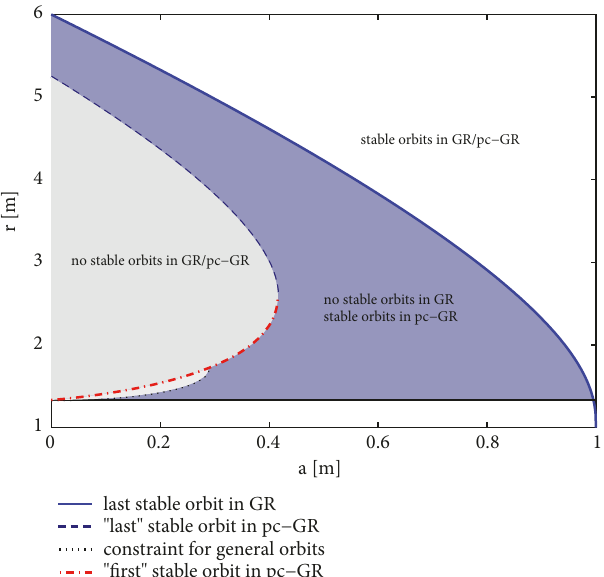
Figure2:Thepositionofthe InnermostStableCircularOrbit (ISCO)isplottedversustherotationalparameter 𝑎 .Theuppercurvecorresponds to GR and the lower curves correspond to pc-GR. The light gray shaded region corresponds to a forbidden area for circular orbits within pc- GR. For small values of 𝑎 the ISCO in pc-GR follows more or less the one of GR, but at smaller values of 𝑟 . From a certain 𝑎 on stable orbits they are allowed until to the surface of the star (for 𝑛 = 3 this limit is approximately 0.4𝑚 and for 𝑛 = 4 it is at 0.5 𝑚